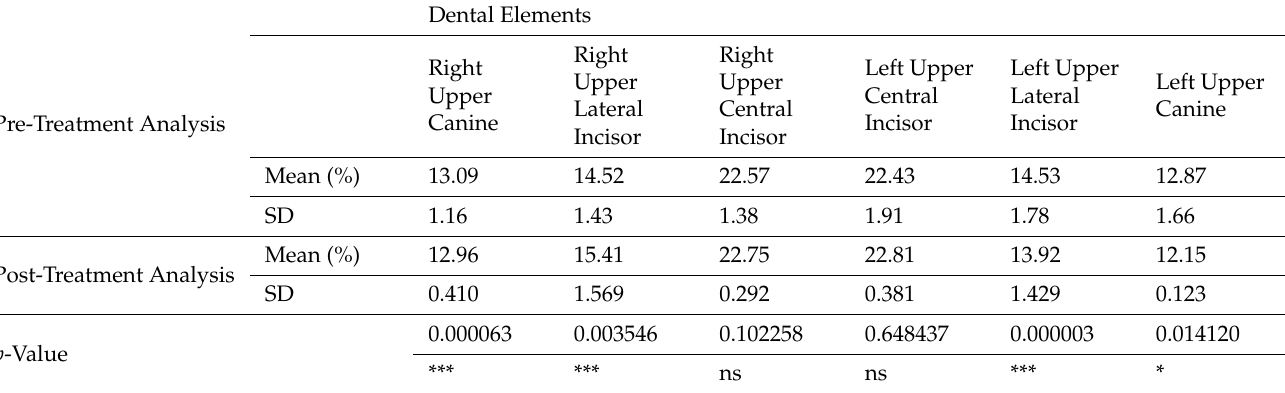
Table 2. Sample values calculated by applying GM theory